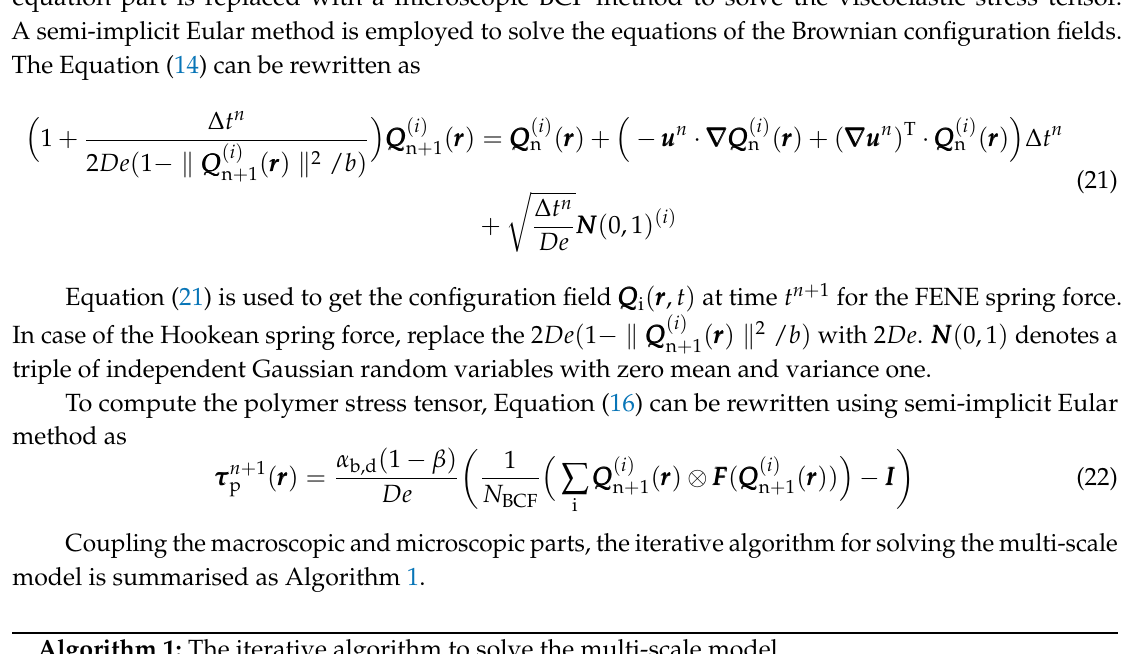
Algorithm 1: The iterative algorithm to solve the multi-scale model. Data: mesh data, initial